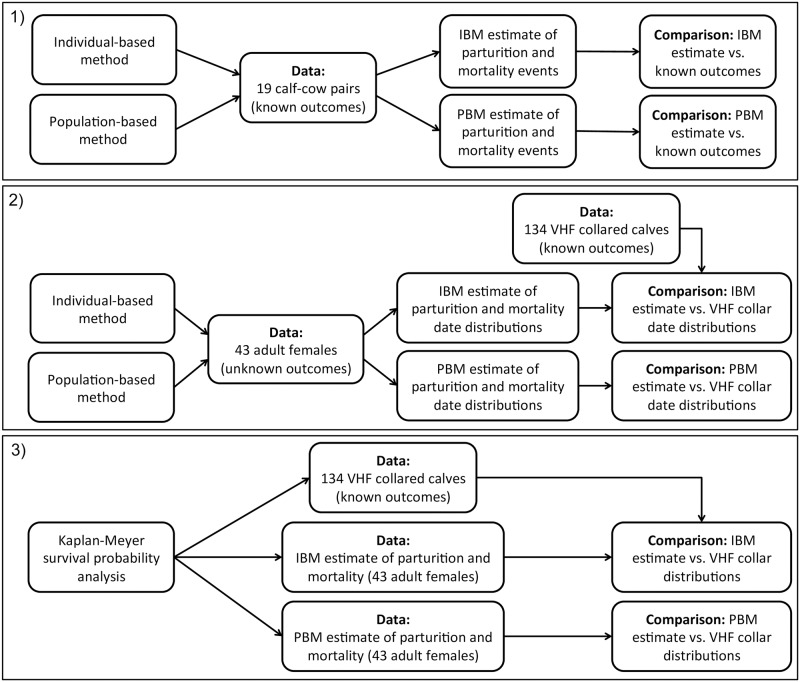
Overview of the DeMars model application to two caribou populations in Newfoundland, Canada.We applied the individual-based method and population-based method in three different ways. 1) We estimated parturition and calf mortality events using the two methods to adults (n = 19) with known parturition and calf mortality events from two different woodland caribou herds in Newfoundland. 2) We estimated herd-wide distributions of parturition and calf mortality dates using the two methods and a multi-year (n = 43) adult telemetry dataset and compared those distributions to the herd-wide distributions of parturition and calf mortality dates derived from concurrent calf telemetry data (n = 134). 3) We generated herd-wide calf survival estimates from Kaplan-Meyer probability curves using the two methods and a multi-year (n = 43) adult telemetry dataset and compared those probability curves to herd-wide survival probability curves derived from concurrent calf telemetry data (n = 134).